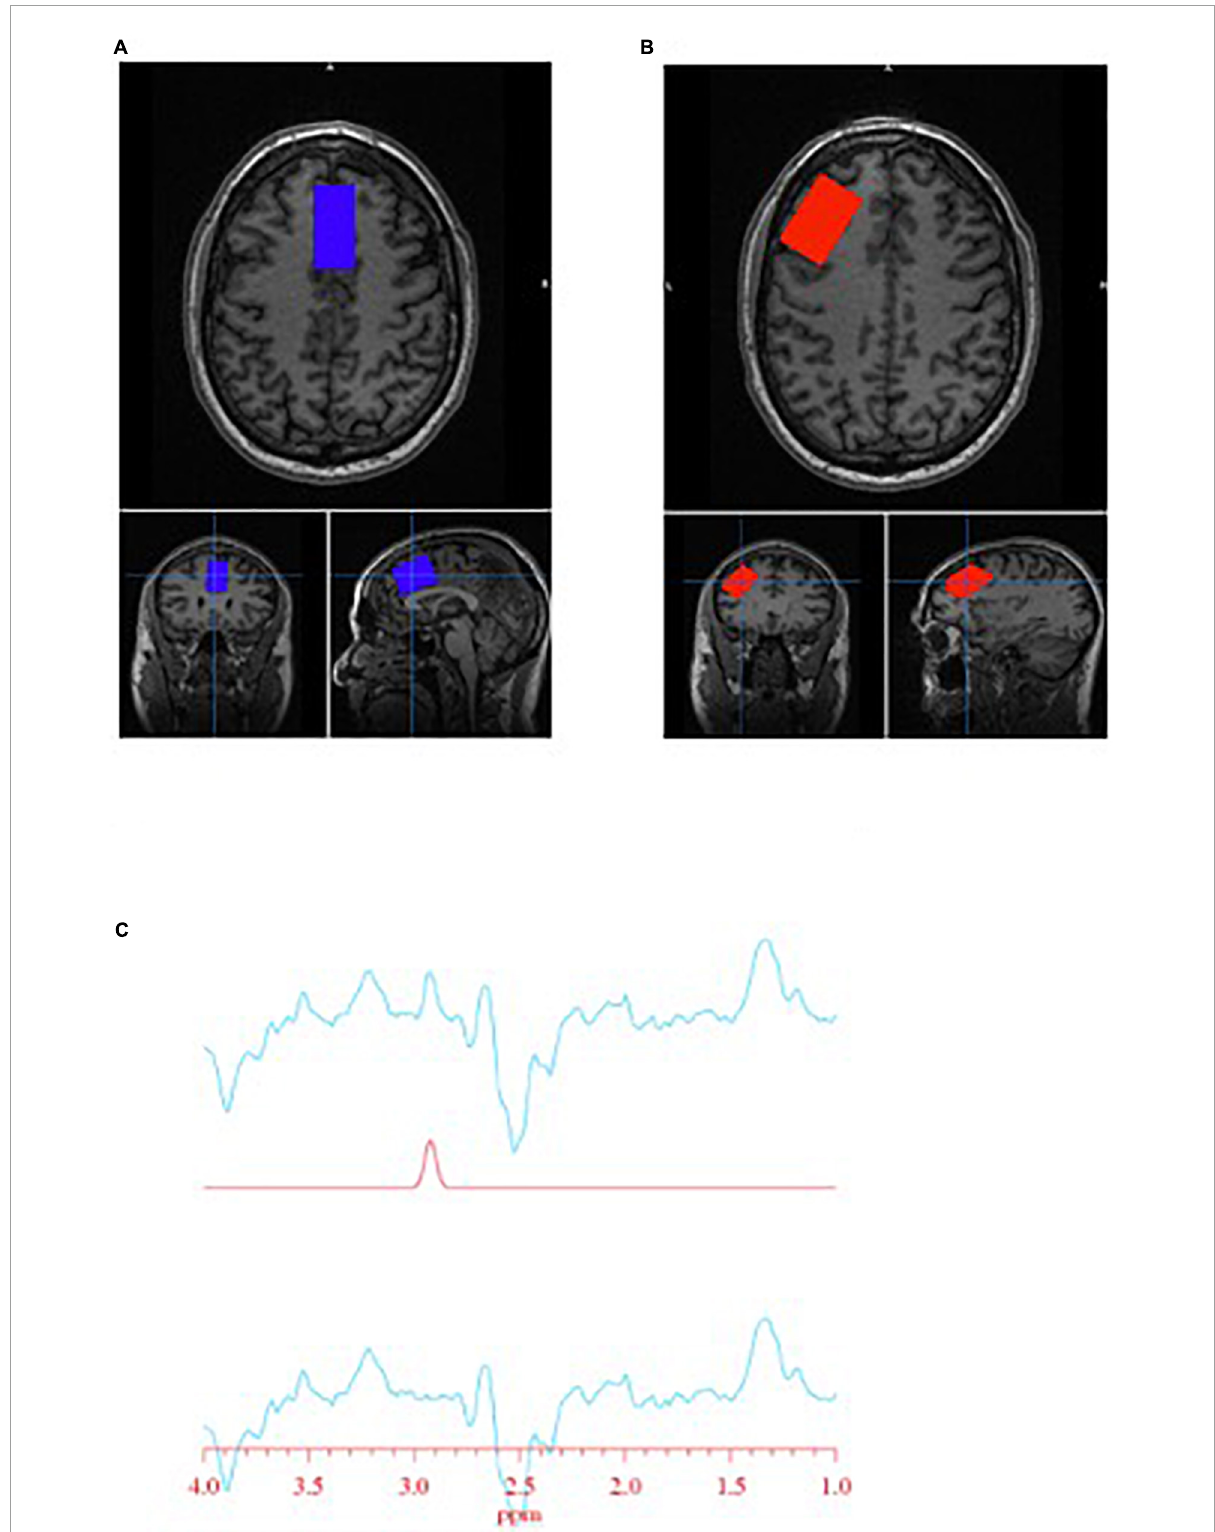
FIGURE1 Glutathione (GSH) metabolite acquisition. (A) Voxel placement in the anterior cingulate cortex (ACC); (B) voxel placement in the left dorsolateral prefrontal cortex (DLPFC); and (C) GSH spectra obtained at 2.95 ppm.